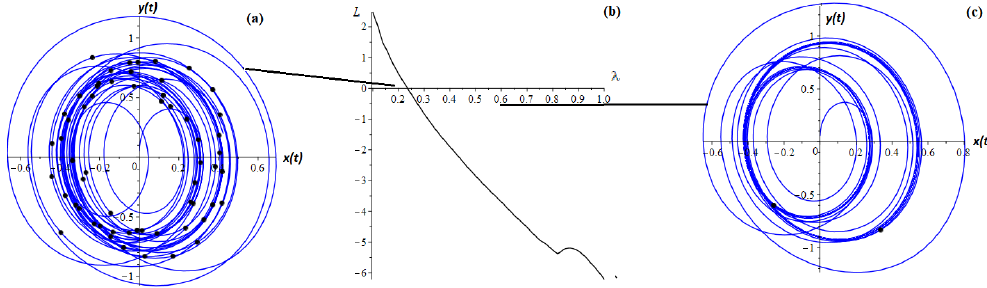
Figure 8. ( a ) Phase trajectories at λ = 0.18, ( b ) the spectrum of Lyapunov exponents from λ and ( c ) phase trajectories at λ = 0.6. The dots represent the Poincare sections.